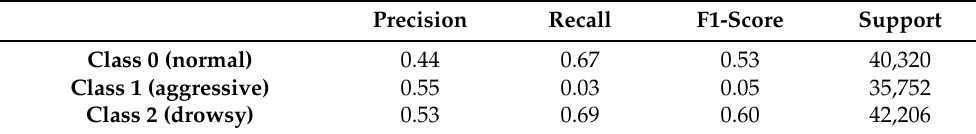
Table 1. Multi-class evaluation metrics with logistic regression classifier for lane detection.